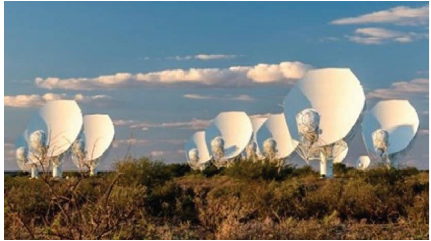
Figure 14: Karoo array telescope (https://africanews.space/a- commercially-driven-african-space-industry/).